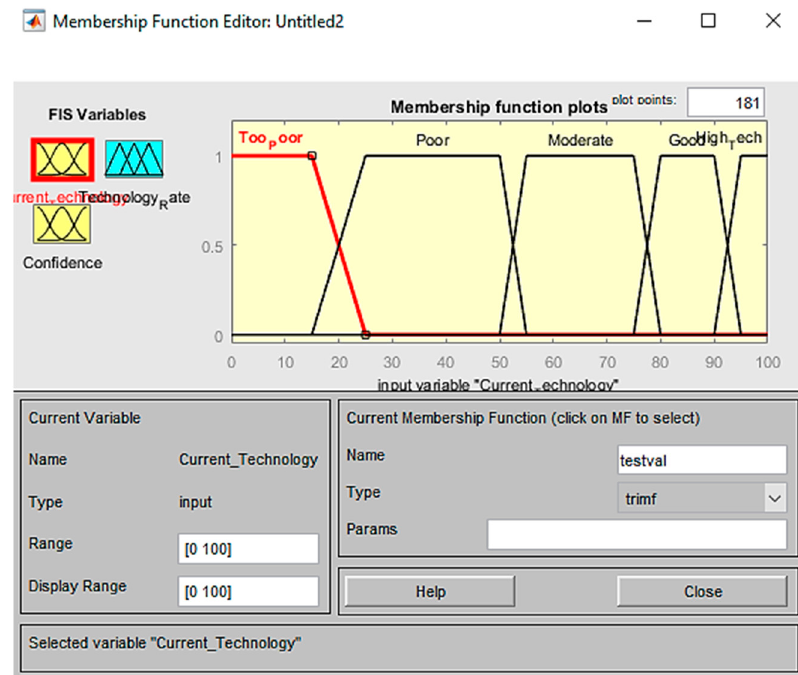
Figure 12. Fuzzy graph for input 1 in the